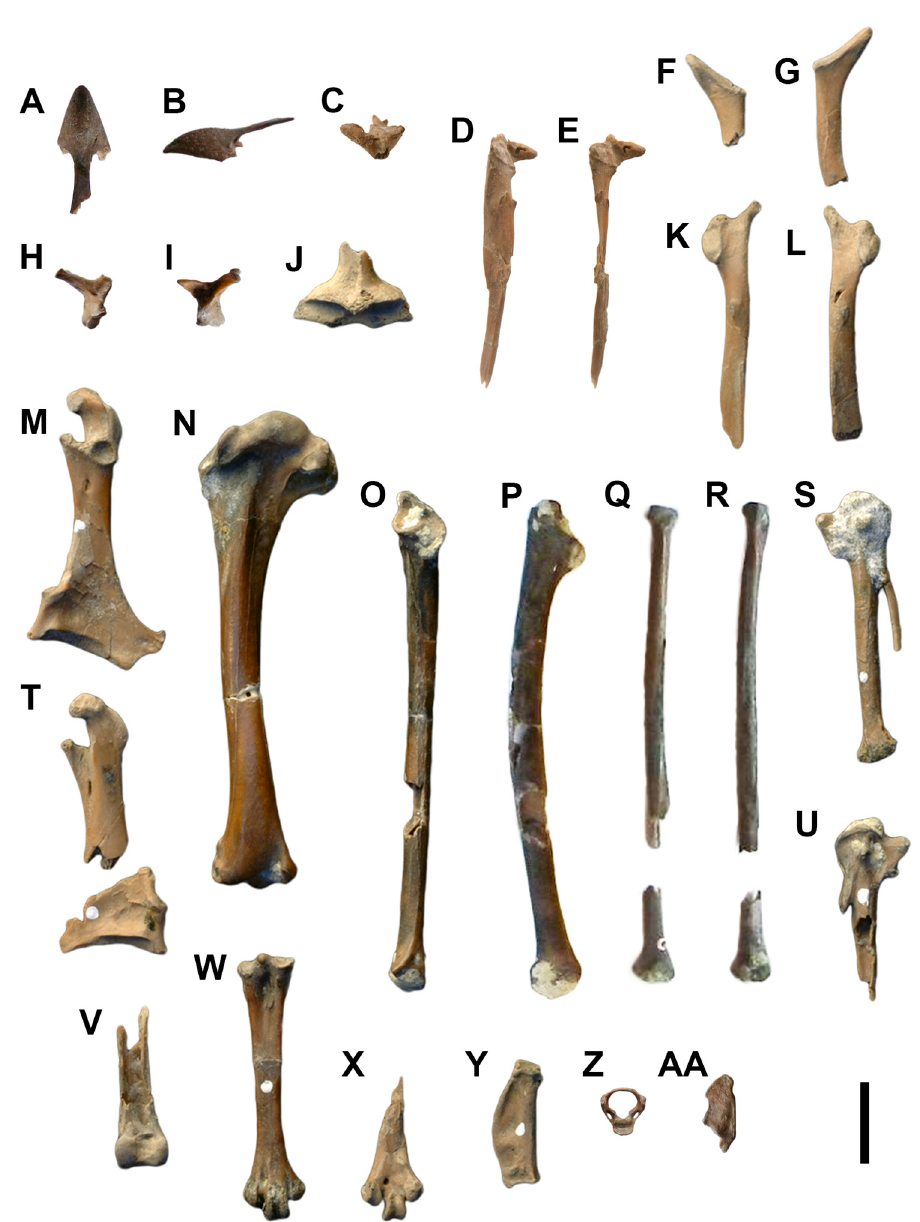
Figure 5. Holotype of Danielsavis nazensis nov. gen. et sp. (NMS.Z.2021.40.1): premaxilla, dorsal ( A ), left lateral ( B ); right side of mandible, caudal ( C ), dorsolateral ( D ), dorsal ( E ); omal extremities of furcula, left ( F ), right ( G ); left quadrate, medial aspect ( H ); right quadrate, medial aspect ( I ); cranial extremity of sternum ( J ); dorsal cranial extremity of scapulae, left ( K ), right ( L ); coracoids right dorsal ( M ), left ventral omal extremity and dorsal sternal extremity ( T ); caudal left humerus ( N ); left ulna, cranial ( O ), dorsal ( P ); radii, left dorsal ( Q ), right caudal ( R ); carpometacarpi, right ventral ( S ), proximal left ventral ( U ); cranial distal right tibiotarsus ( V ); tarsometatarsi, right cranial ( W ), left caudal ( X ); ventral left proximal major digit ( Y ); caudal atlas ( Z ); left lateral pygostyle ( AA ). Scale bar 1 cm. Images F, G, K-O, and S-X courtesy of Gerald Mayr. Vertebrae: The atlas bears transverse foramina. Most cervical vertebrae are approxi-